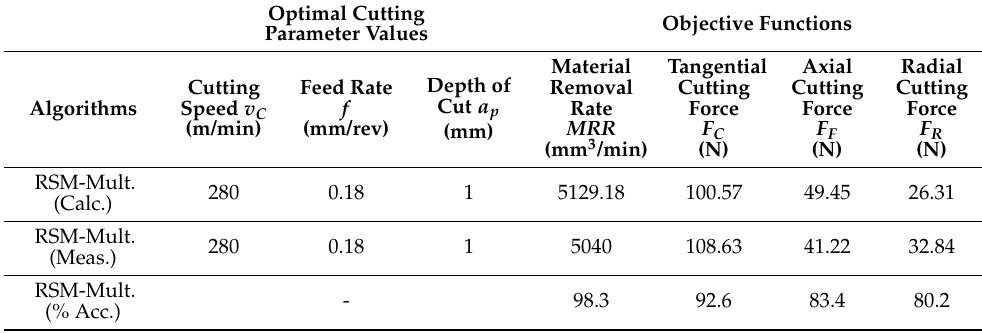
Table 6. The optimization results for